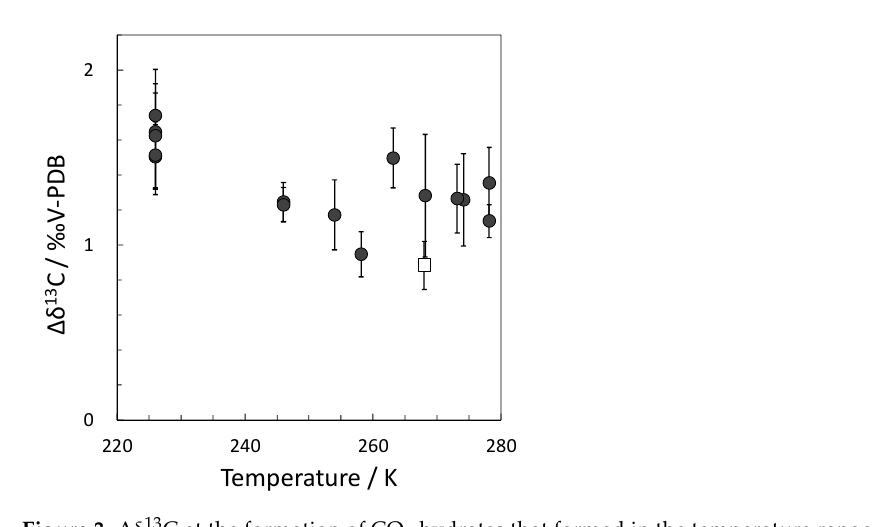
Figure 3. Δδ 13 C at the formation of CO 2 hydrates that formed in the temperature range of 226–278 K. (Solid circles, this work; open square, literature) [17].